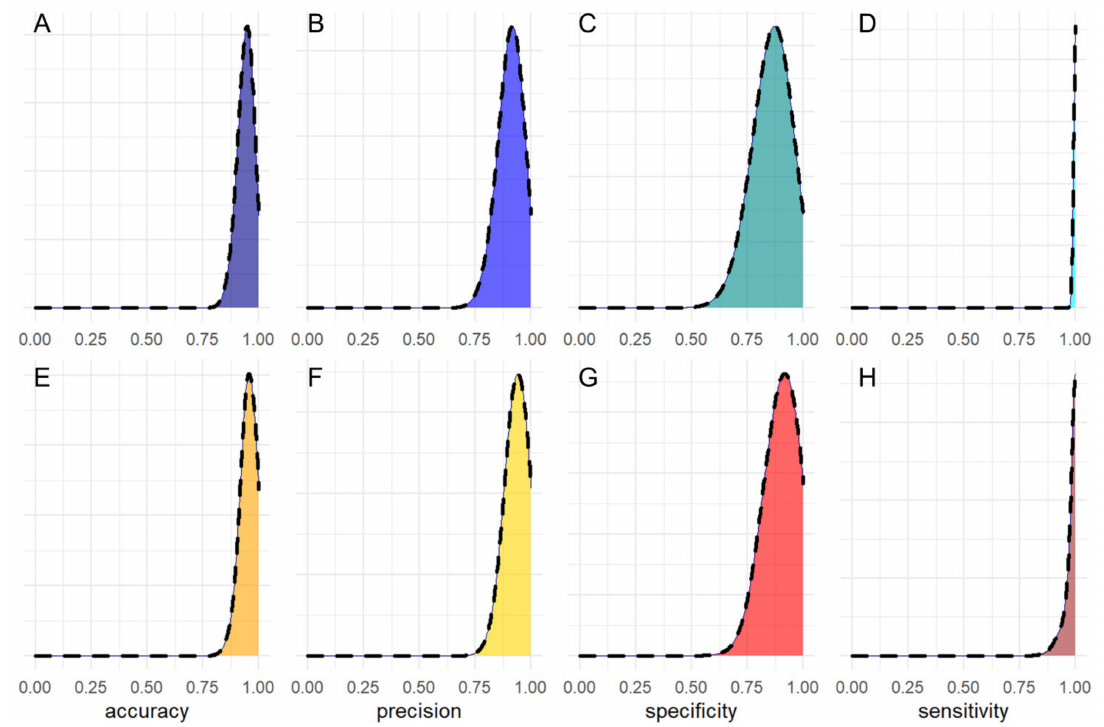
Figure 3. Bootstrap distribution of accuracy ( A , E ), precision ( B , F ), sensitivity ( C , G ) and specificity ( D , H ) for λ (upper panels) and λ + IgA2 ( E – H ).